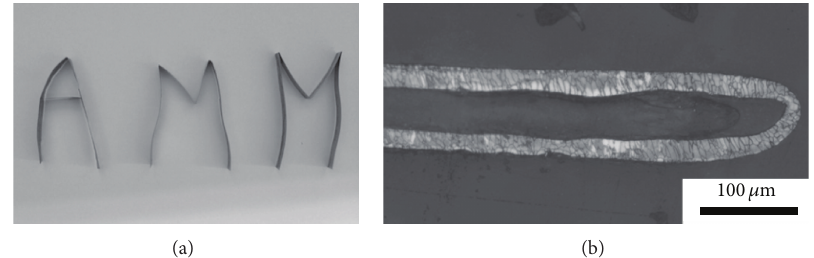
Figure 3: Rapidly quenched ribbons possess good bending ductility: (a) ribbons are bent into 180 ∘ and (b) no cracks are found after bending.